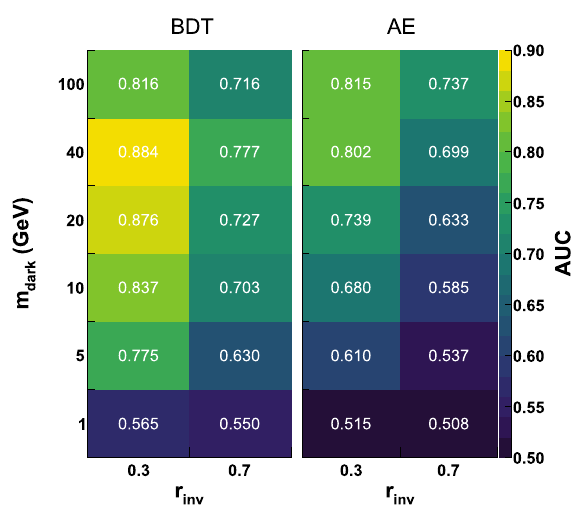
Fig. 53 Comparison of AUC values of the autoencoder and BDT with varying m D values (here called m dark ). The BDT was trained on a mix- ture of all signals with m D = 20 GeV. This figure is reproduced from Ref.